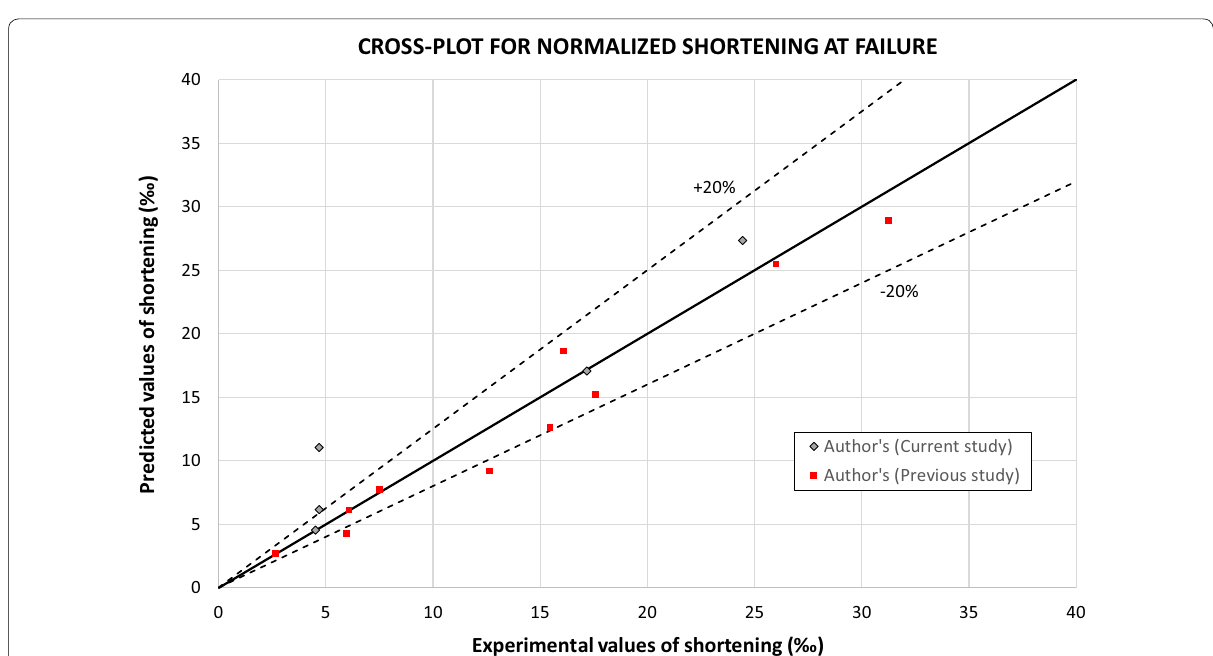
Fig. 16 Cross-plot of experimental values of normalized shortening for ultimate failure load versus analytical values found from the regression Eq. (4) for specimens of the current research and specimens found in the